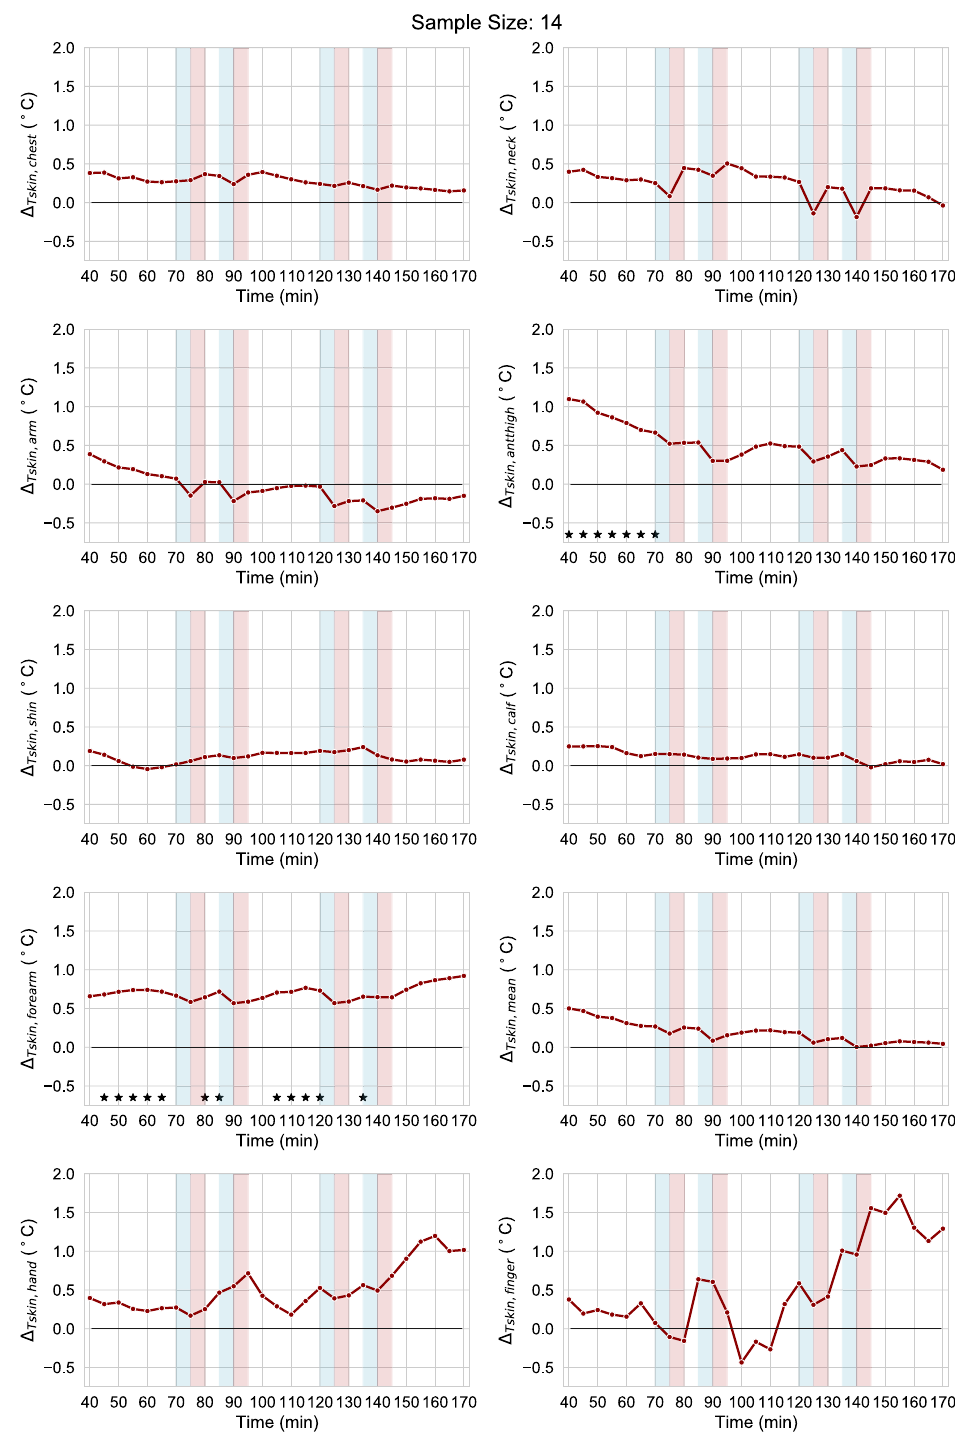
Figure 5. Mean difference (Δ) between the evening and afternoon values of the skin temperature at different locations. Asterisks indicate statistically significant